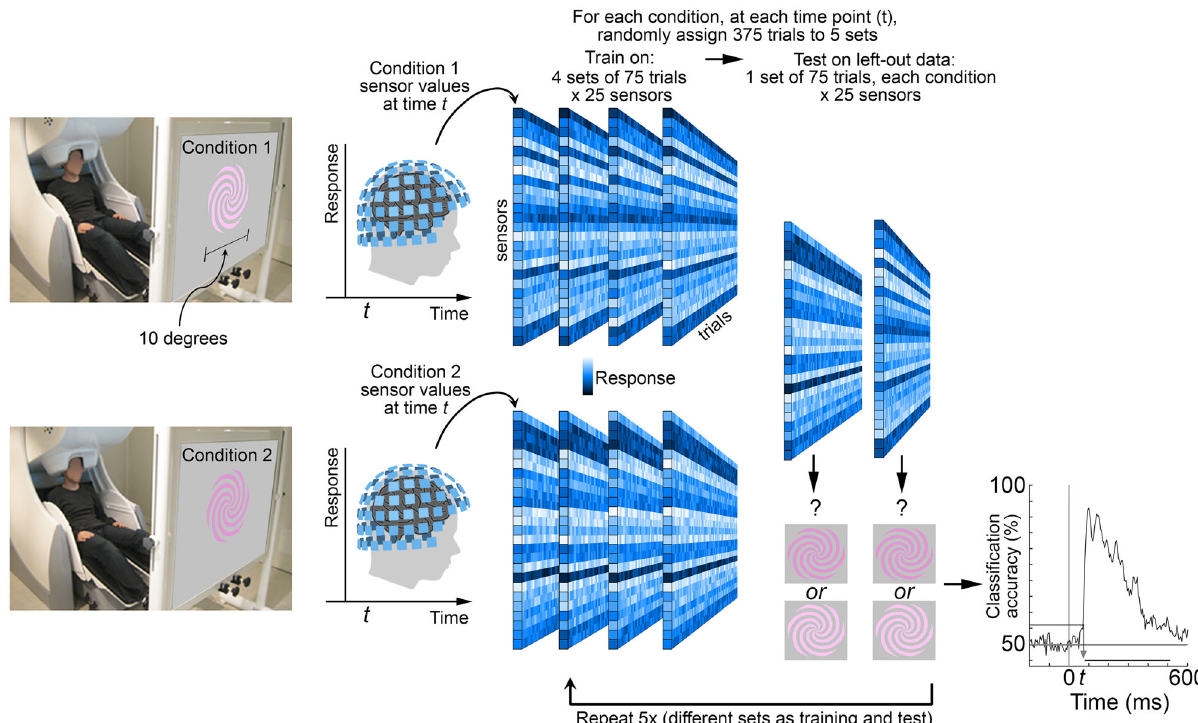
Fig. 2 Experimental paradigm. Participants were scanned with magnetoencephalography (MEG) while they looked at colored spirals that were fl ashed on the screen for 116 ms (with 1 s between fl ashes). The spirals were one of eight colors: four hues of either a luminance increment or luminance decrement (Supplementary Fig. 1 provides the color speci fi cations for the stimuli). Stimuli were pseudo-randomly interleaved, with 500 presentations of each stimulus over two recording sessions for each of 18 participants. Trials during eye blinks or other artifacts were removed, and the remaining trials were randomly subsampled to yield 375 trials per condition. Sensor data were averaged into 5 ms bins, 200 ms before stimulus onset to 600 ms after stimulus onset. The fi gure depicts the experimental set up and simulated data to illustrate the analysis pipeline. Classi fi ers were trained at every time point, and individually for each participant: at each time point ( t ) in the 800-ms time window, the 375 trials were divided into fi ve sets of 75. Four sets were used to train the classi fi er, and one set was used to test the classi fi er. The procedure was repeated for the fi ve cross-validation splits; and the entire procedure was repeated 50 times, with different random assignments of the 375 trials into the fi ve sets, yielding a decoding curve showing classi fi cation accuracy as a function of time after stimulus onset (bottom right showing actual data for classifying luminance polarity using pink). The horizontal sequence of data points above the x -axis shows the time points when decoding was signi fi cant for more than four consecutive time points (FDR-corrected; the gray arrow shows the classi fi cation accuracy and the time point at which decoding became signi fi